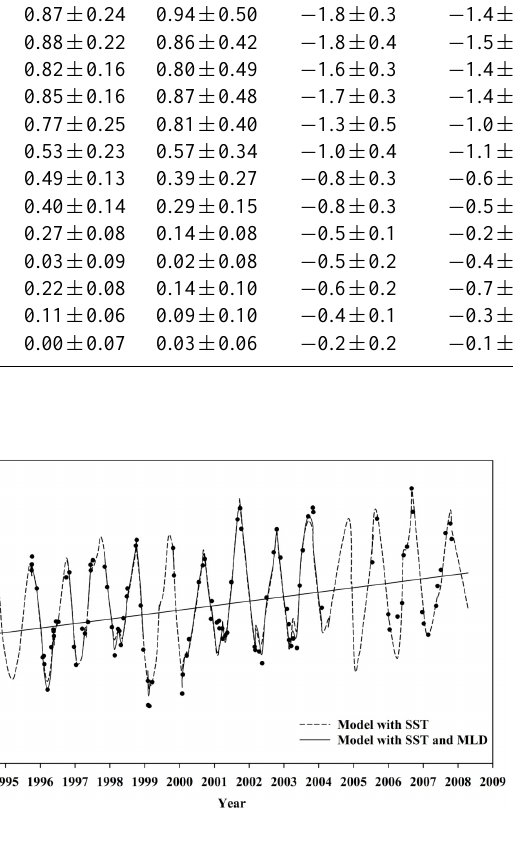
Fig. 3. Long-term trends of surface (10m) oceanic partial pres- sure of CO 2 expressed as fugacity, f CO 2 , observed at the ESTOC site (European Station for Time series at the Ocean, the Canary Is- lands) (29 ◦ 10 0 N, 15 ◦ 30 0 W) located north of the Canary Islands in the North East Atlantic Ocean. The model fit corresponds to Eq. (4) (continuous line) for data from September 1995 to February 2004 considering the sea surface temperature (SST) and the mixed layer depth (Santana-Casiano et al., 2007) and to Eq. (5) (dotted line) that uses SST from 1995 to 2008 and applied to the full data set of ESTOC. The slope of the regression line is 1 . 75 ± 0 . 37µatmyr − 1